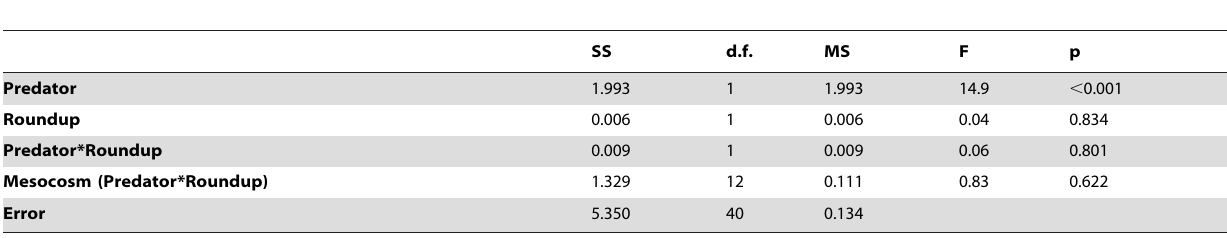
Table 3. ANOVA using CT max as dependent variable, predator cues and Roundup as categorical factors (including the interaction of these factors) and, mesocosm nested within the interaction of predator cues and Roundup, for Hyla versicolor .